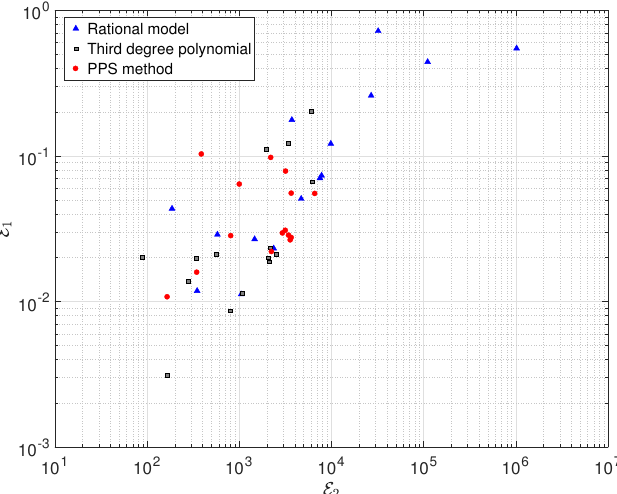
Figure 8. The locus of E 1 and E 2 obtained with the PPS method and Equations (12) and (13) for the set of 15